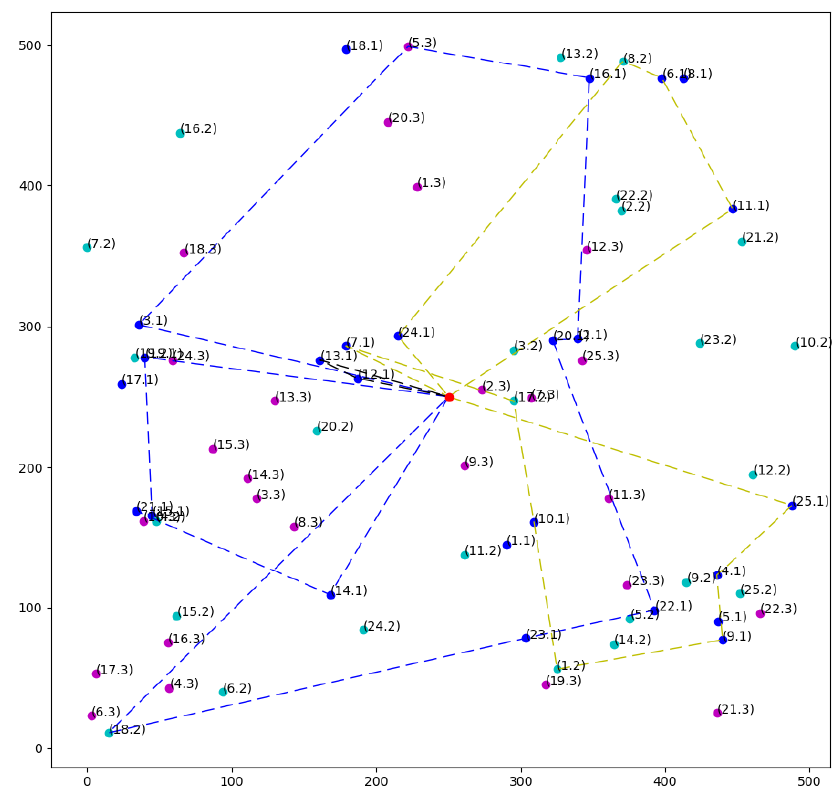
Figure 2. Example of routes for a problem with 25 customers and 3 possible options. Table 4 shows the results obtained by the evolutionary procedure (EP) for three simulation batteries (25, 50, and 100 customers) where priorities were declared by the customers. Every instance was run 50 times. The table shows the best value, the average value of the fitness values obtained (OF), the cost, and the priority. The gap between the average value and the best value is shown to demonstrate the convergence of the procedure. Table 4. Results of the EP with priority